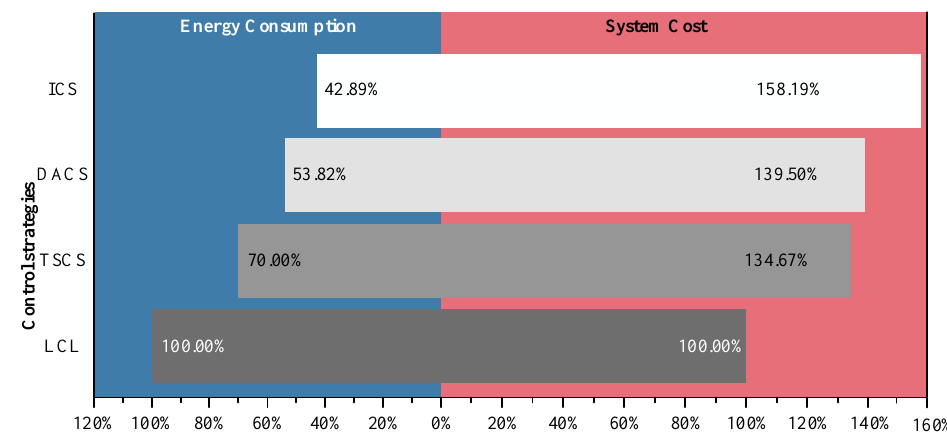
Figure 4. Relationship between control strategy and energy consumption/system cost. Table 3. Lighting control strategies’ analysis. Table 2. Comparison of initial installation costs for various control strategies in Madang tunnel.